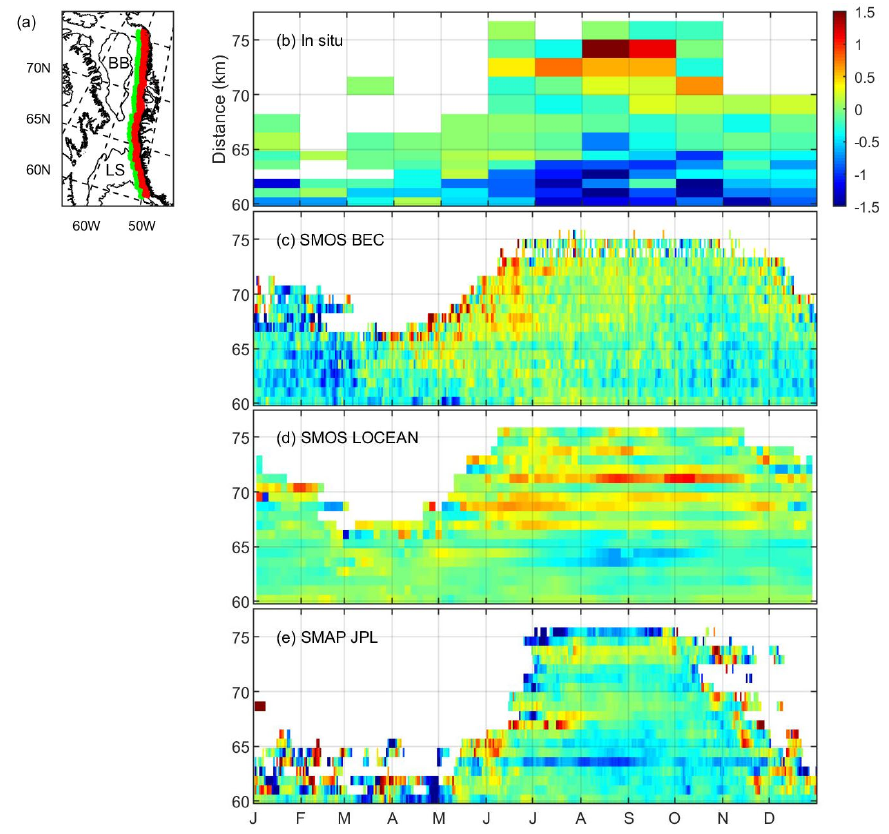
Figure 4. ( a ) Study area. BB: Baffin Bay; LS: Labrador Sea. Hovmöller diagram (month vs. latitude) of difference between surface salinity data averaged within 60 km from the west Greenland coast (area shown in red in panel a ) and data averaged between 60 and 110 km from the coast (area shown in green in panel a ) based on ( b ) in situ data, ( c ) SMOS BEC, ( d ) SMOS LOCEAN, and ( e ) SMAP JPL.